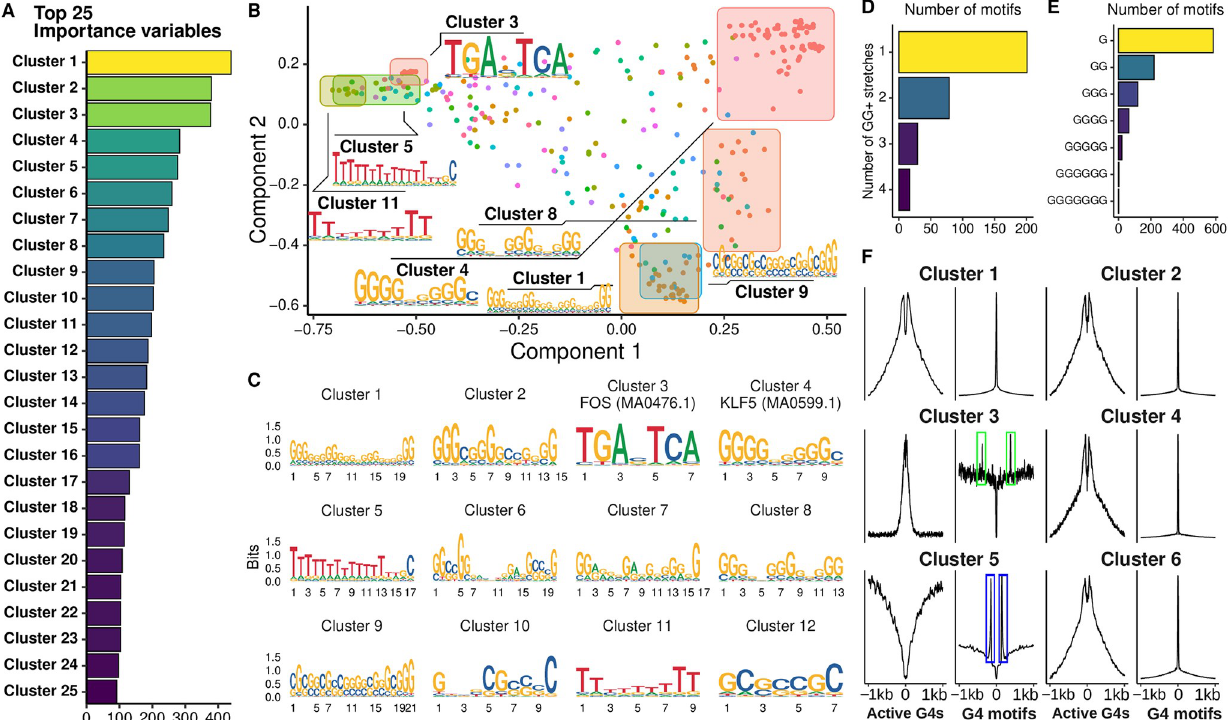
Fig 4. DNA motifs identified by DeepG4. A) Variable importances of DeepG4 cluster motifs, as estimated by random forests. Clustering of DeepG4 kernel motifs was done by RSAT matrix-clustering program to obtain cluster motifs. B) Multidimensional scaling (MDS) of DeepG4 motifs. As an input, matrix-clustering correlation matrix between kernel motifs was used. C) Logos of cluster motifs with highest variable importances. D) Number of kernel motifs containing one or more GG+ stretches. A GG+ stretch is defined as a stretch of 2 or more Gs in the motif consensus sequence. E) Number of kernel motifs containing G stretches depending on stretch length. F) Average profiles measuring the enrichment of cluster motifs centered around active G4 regions or canonical G4 motifs.